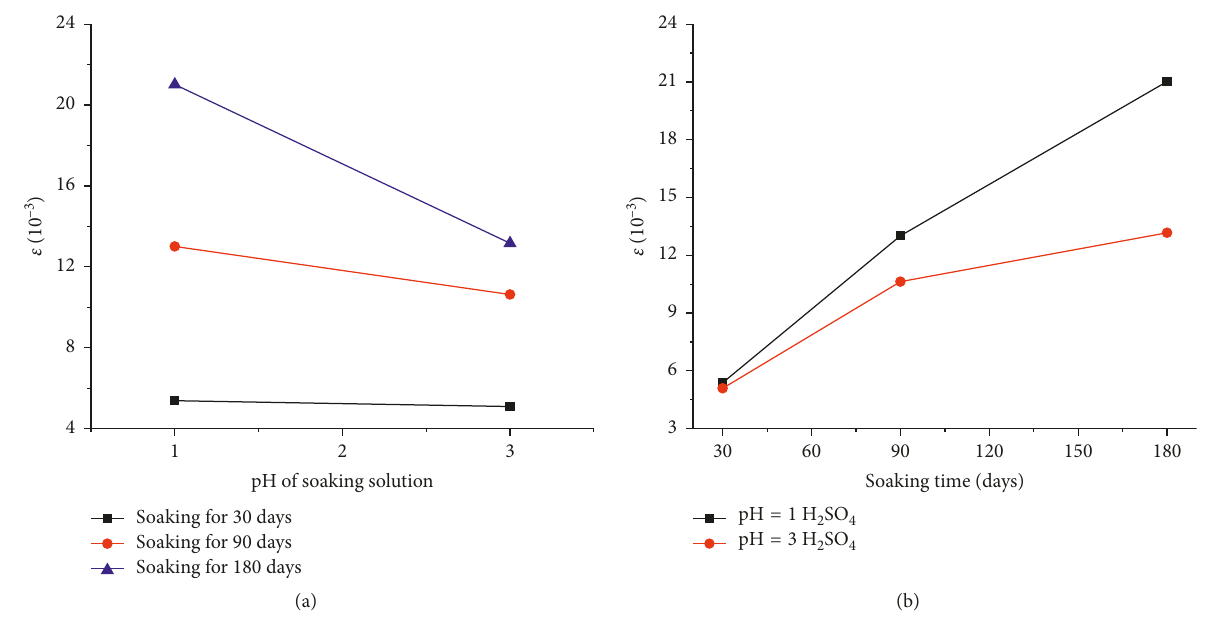
Figure 9: Relationships between axial peak strains of samples and (a) pH of solutions and (b) immersion